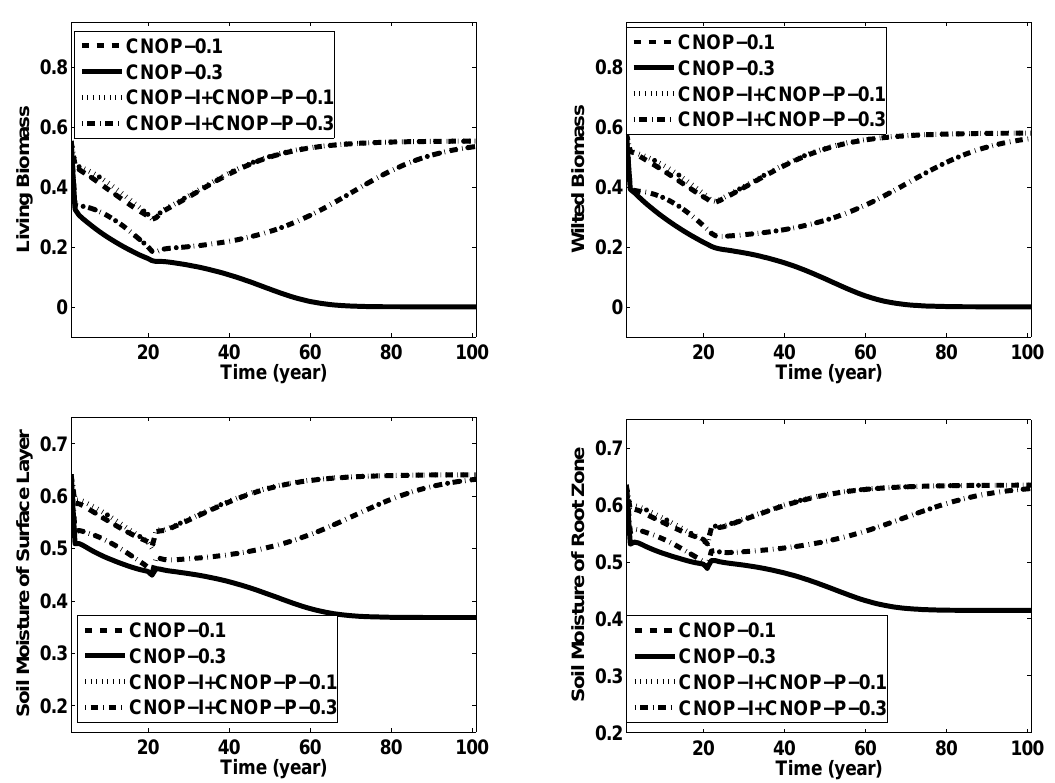
Fig. 3. The nonlinear evolutions in grassland ecosystems for different CNOPs when δ 2 = 0 . 22. CNOP-0.1 implies that the grassland ecosystem is caused by the perturbations obtained by optimizing the Eq. (3) when δ 1 = 0 . 1 and δ 2 = 0 . 22. CNOP-0.3 is same as CNOP-0.1, only when δ 1 = 0 . 3. CNOP-I+CNOP-P-0.1 implies that the grassland ecosystem is caused by the perturbations obtained by optimizing the Eqs. (5) and (7) when δ 1 = 0 . 1 and δ 2 = 0 . 22. CNOP-I+CNOP-P-0.3 is same as CNOP-I+CNOP-P-0.1, only when δ 1 = 0 . 3. The living biomass (top left), the wilted biomass (top right), the soil moisture of surface layer (bottom left), and the soil moisture of root zone (bottom